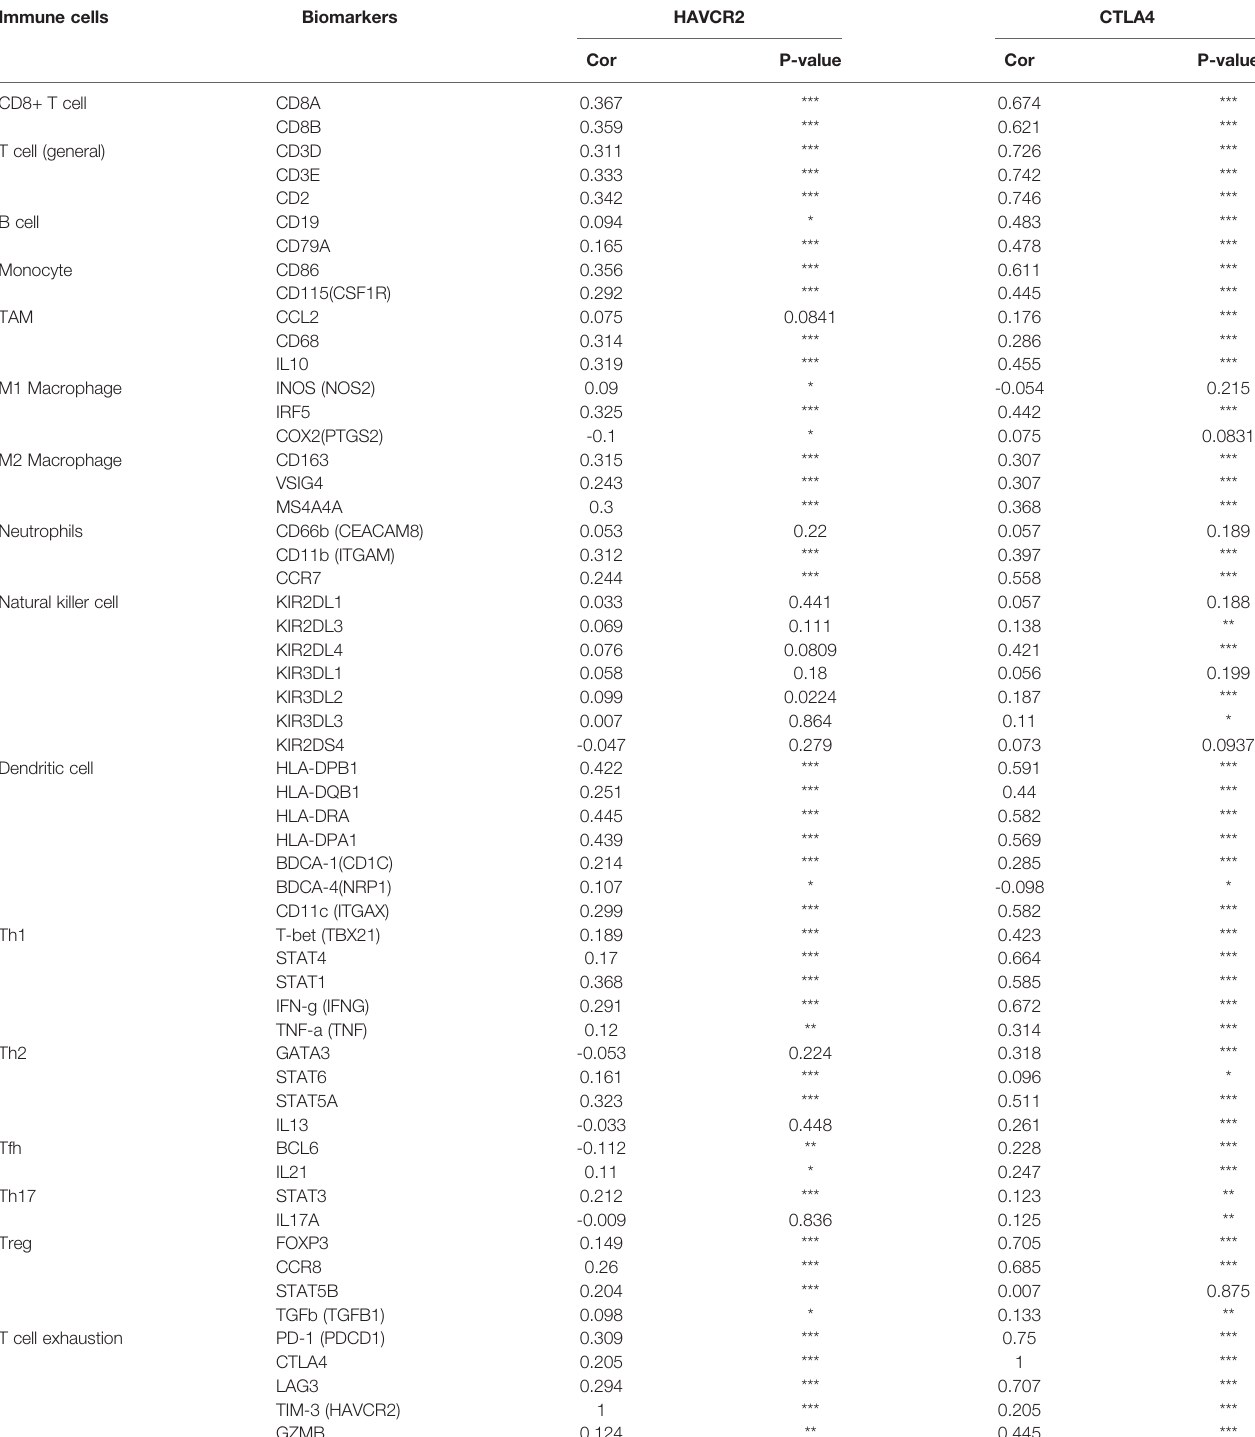
TABLE 2 | Correlation analysis between HAVCR2/CTLA4 and gene biomarkers of immune cells in KIRC. Immune